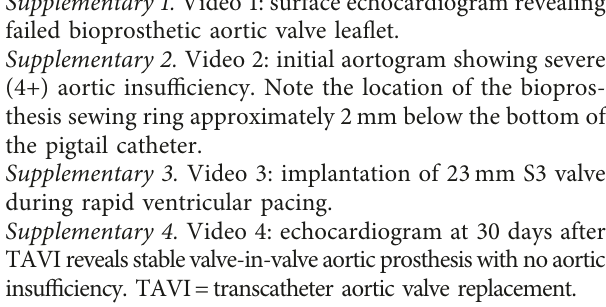
Supplementary 1. Video 1: surface echocardiogram revealing